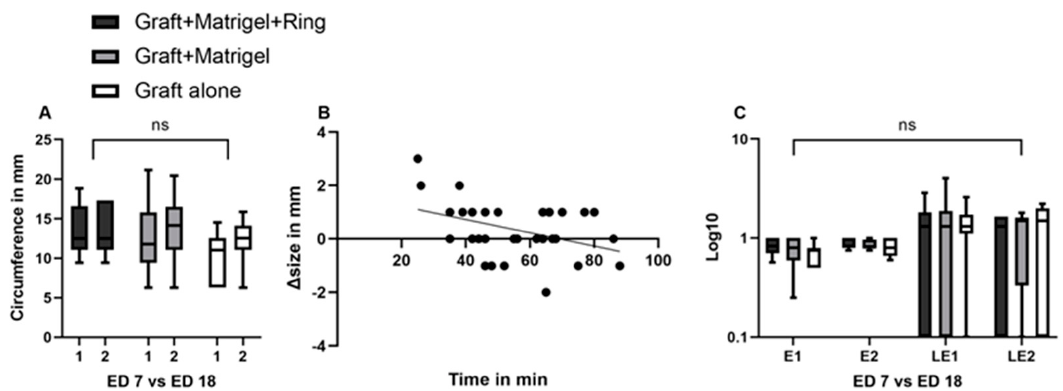
Figure 6. Characterization of uveal melanoma patient-derived grafts: comparison of circumference, ellipticity, and linear eccentricity between ED7 and ED18, as well as among groups 1, 2, and 3. Association and effect of time interval on tumor size. ( A ) A non-significant increase was documented among the three groups or during the growth period for each group, ( B ) linear regression of the time interval between enucleation and engraftment onto the CAM and the difference in size between ED7 and ED18, ( C ) a non-significant increase was documented regarding the ellipticity and the linear eccentricity of the tumor grafts during the growth period and among the tested groups. A Log10 scale was used for the Y axis. Statistical analysis was performed using a two-way ANOVA and Tukey’s multiple comparisons test. ns = non significant.